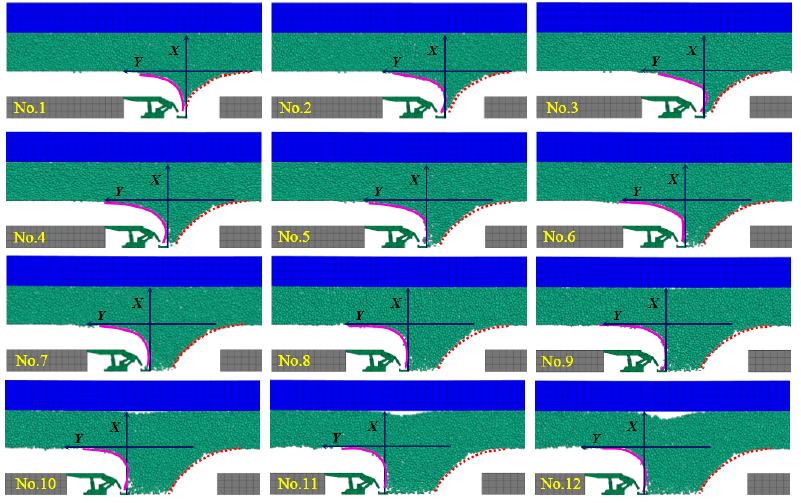
Figure 11. The evolutional process of